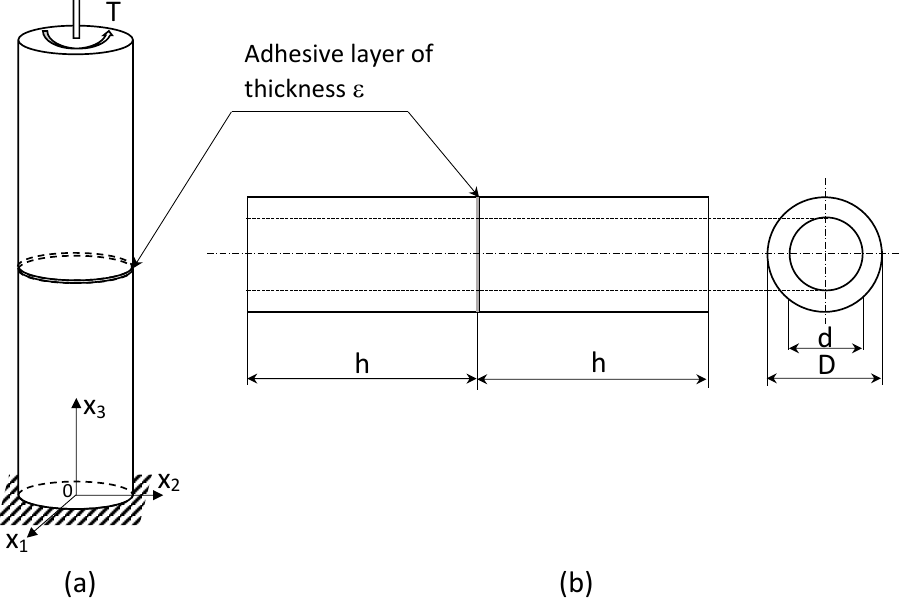
Figure 1. ( a ) Sketch of the tube-to-tube joint with the loading configuration. ( b ) Longitudinal and traversal sections with